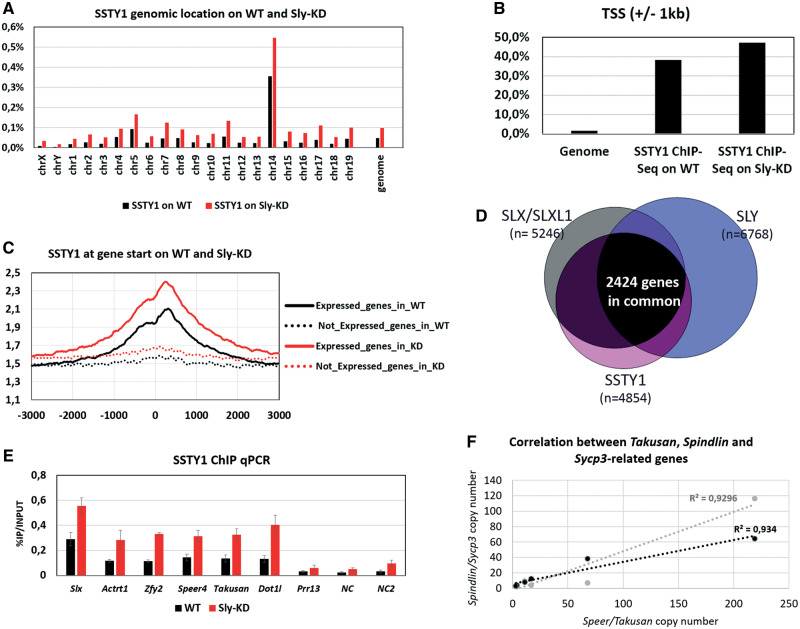
SSTY1 colocalizes with SLX/SLXL1 and SLY at the TSS of spermatid-expressed genes. Unless stated otherwise, the data presented in this figure represent the intersection of two independent experiments (i.e., regions found in common in the replicates); see supplementary figure S6, Supplementary Material online, for individual data. (A) SSTY1 genomic location (% of coverage of each chromosome) as identified by ChIP-Seq on WT (black) and Sly-KD (red) round spermatids. (B) Graphic representation of SSTY1 enrichment at the TSS of genes (±1 kb) in WT and Sly-KD spermatids (χ2, P < 0.0001 for both). (C) Graphic representation of SSTY ChIP-Seq profile in WT (black lines) and Sly-KD (red lines) round spermatids showing the average enrichment around the TSS of genes expressed (unbroken lines) and not expressed (dotted lines) in round spermatids. (D) Venn diagrams representing the number of common target genes between SLY (all target genes in WT round spermatids), SSTY1, and SLX/SLXL1 (all target genes in WT and Sly-KD round spermatids). The number of target genes presented for SLY is slightly different than in figure 1D (i.e., 6,768 genes instead of 7,280) because, for the sake of appropriate comparison between data sets, the bioinformatics pipeline chosen was the one described in supplementary tables S2 and S3, Supplementary Material online (and not supplementary table S1, Supplementary Material online). (E) SSTY1 ChIP-qPCR performed on WT and Sly-KD round spermatids. The Y-axis represents the mean enrichment (% IP/input) ± SEM (n = 3–4 samples per genotype). A significant difference (t-test, P < 0.05) was found for all regions shown on the graph except Prr13 and Actrt1. (F) Scatter plot showing numbers of coding Speer/Takusan genes corresponding to Sycp3- or Spindlin-related genes in rodents (respectively, gray and black dots) from supplementary table S5, Supplementary Material online. R2 indicates the coefficient of each regression line.